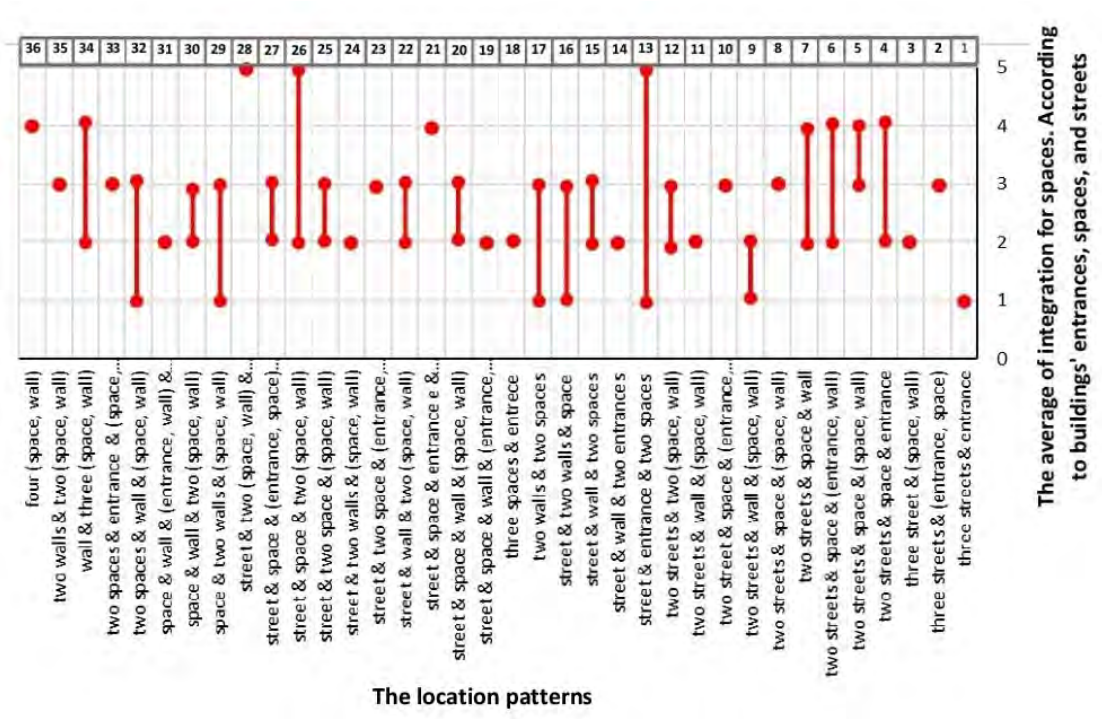
Figure 5. The relation between the space location patterns and the average of integration forspace according to surrounding buildings’ entrances, spaces, and